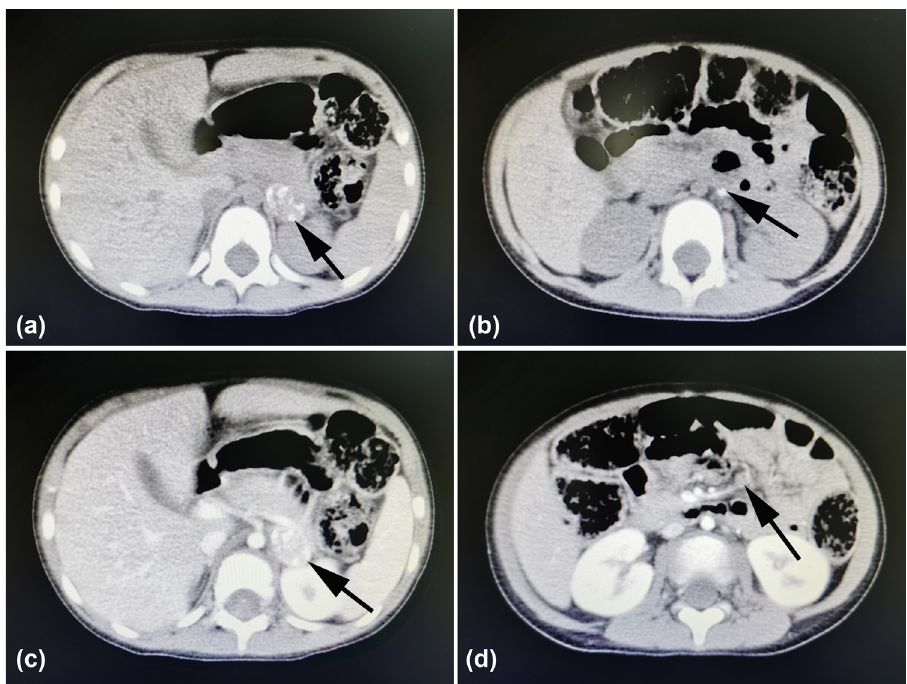
Figure 5: Abdominal CT fi ndings. ( a ) A plain scan showing a left adrenal tumor of approximately 1.5 cm × 2.2 cm × 2.7 cm size ( black arrow ) ; ( b ) a plain scan showing a calci fi ed nodule on the left side of the abdominal aorta ( black arrow ) ; ( c ) an enhanced scan revealing left adrenal tumor with increased calci fi cation inside ( black arrow ) ; ( d ) an enhanced scan showing the mesenteric lymph nodes ( black arrow ) .